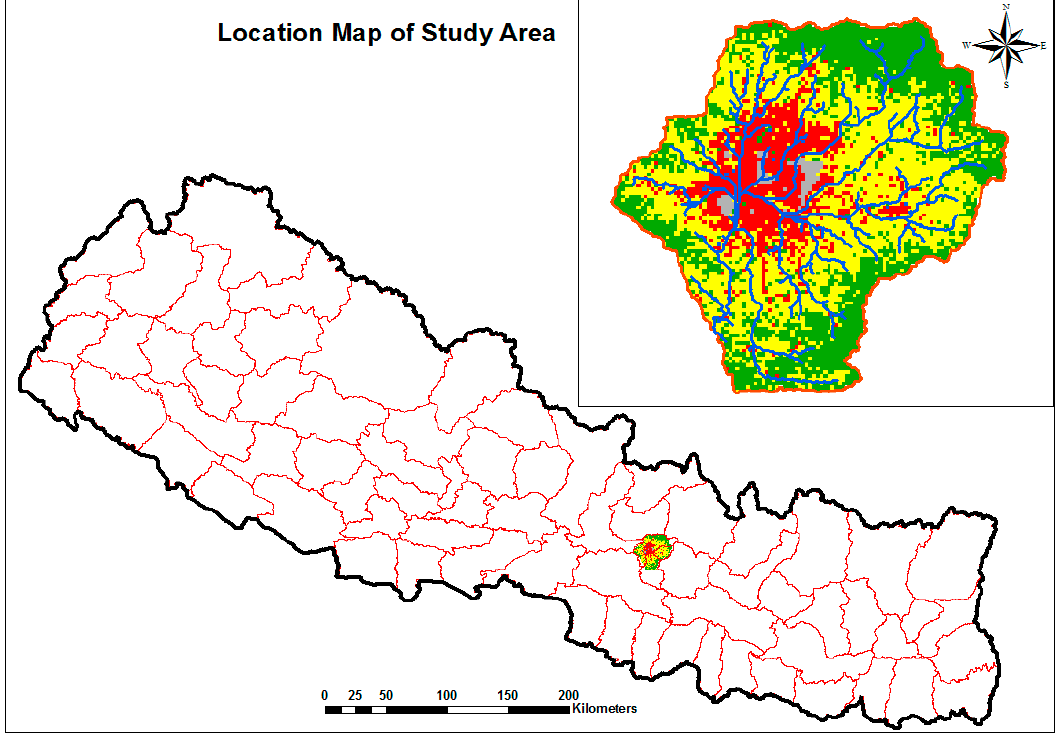
Figure 1. Location map of the study area in central Nepal.